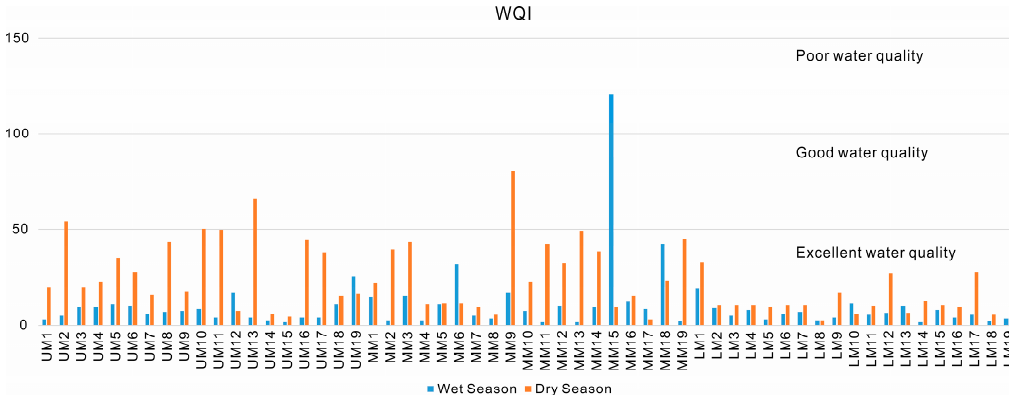
Figure 6. Water quality index (WQI) values of water in the Mun River.